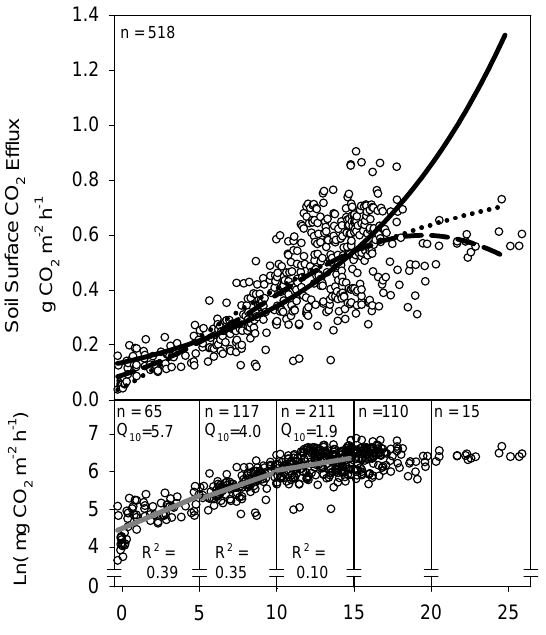
Q 10 =2.5 R 2 = 0.67